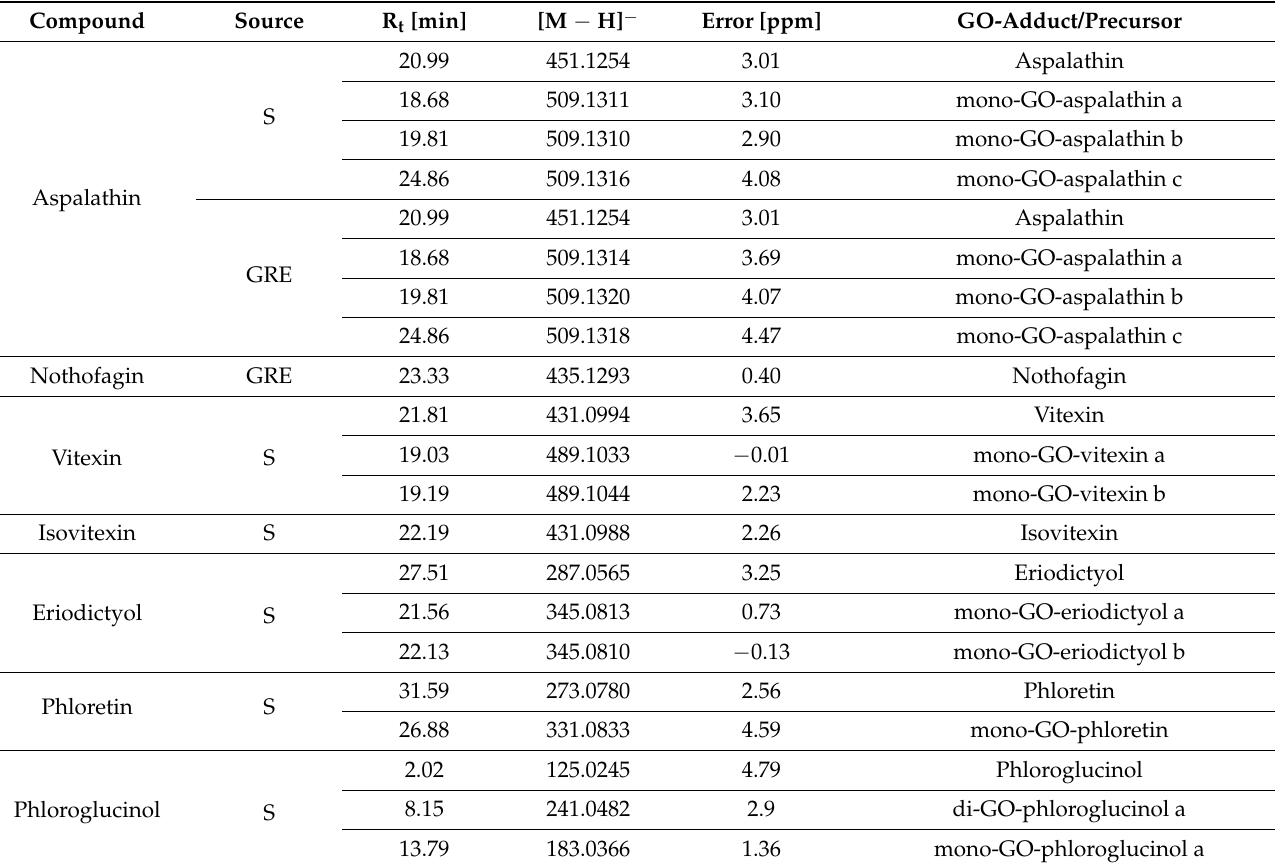
Table 4. Adducts of glyoxal and investigated compounds formed after 1 h of incubation in pH 7.4 phosphate buffer solution at 37 ◦